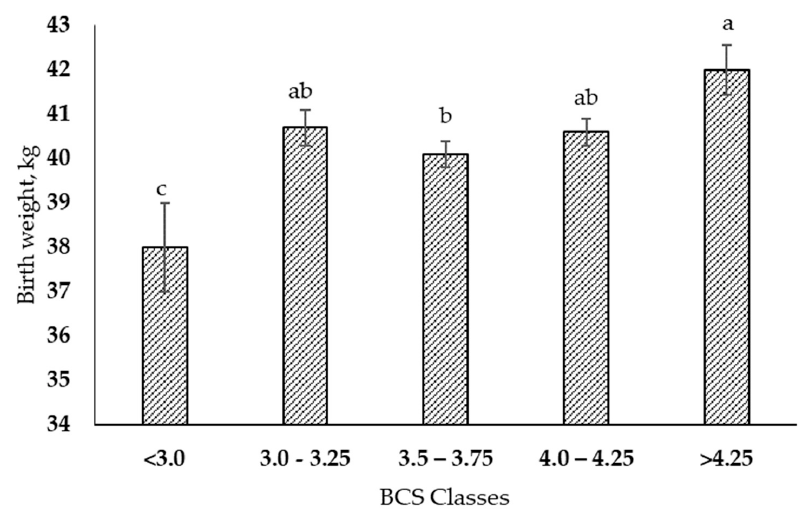
Figure 1. Effect of maternal body condition score on the birth weights of their offspring. a–c Bars with different superscripts differ significantly ( p < 0.05). Error bars indicate the standard error of the mean. Table 3. Effect of body condition score at calving on the performance of cows and their offspring.